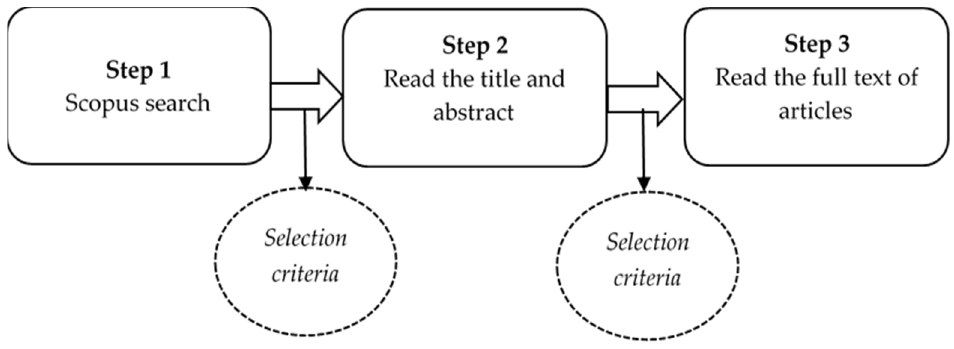
Figure 2. Article selection process.